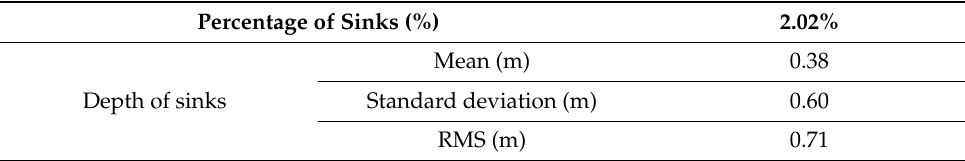
Table 1. Percentage and depth of sinks in P-band